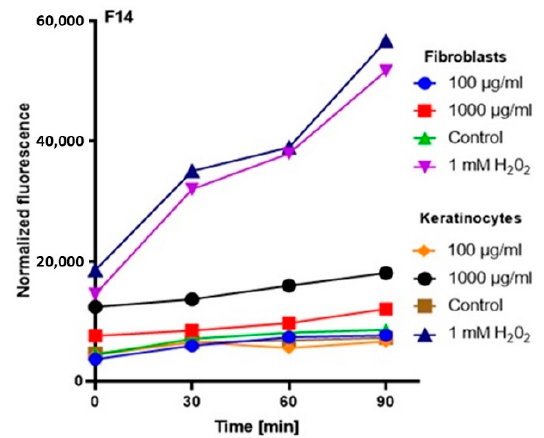
Figure 5. The effect of kombucha ferments’ extracts (F14) on the DCF fluorescence in fibroblasts and HaCaT cells. The data are expressed as the mean ± SD of 3 independent experiments, each of which consisted of 3 replicates per treatment group.